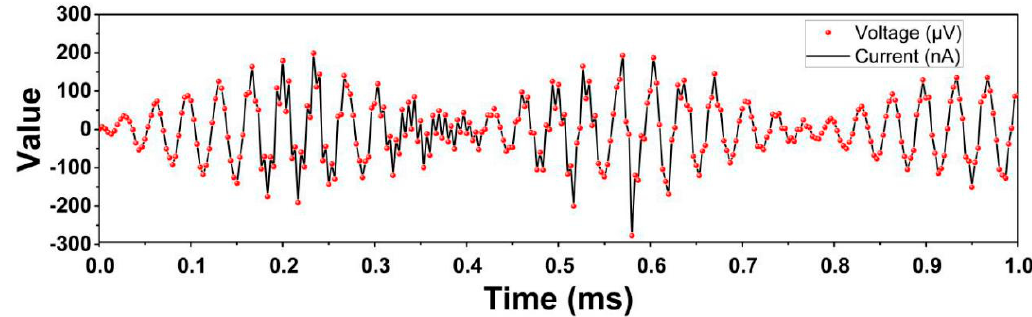
Figure 12. Current–voltage response diagram under sine wave (of cylinder modified